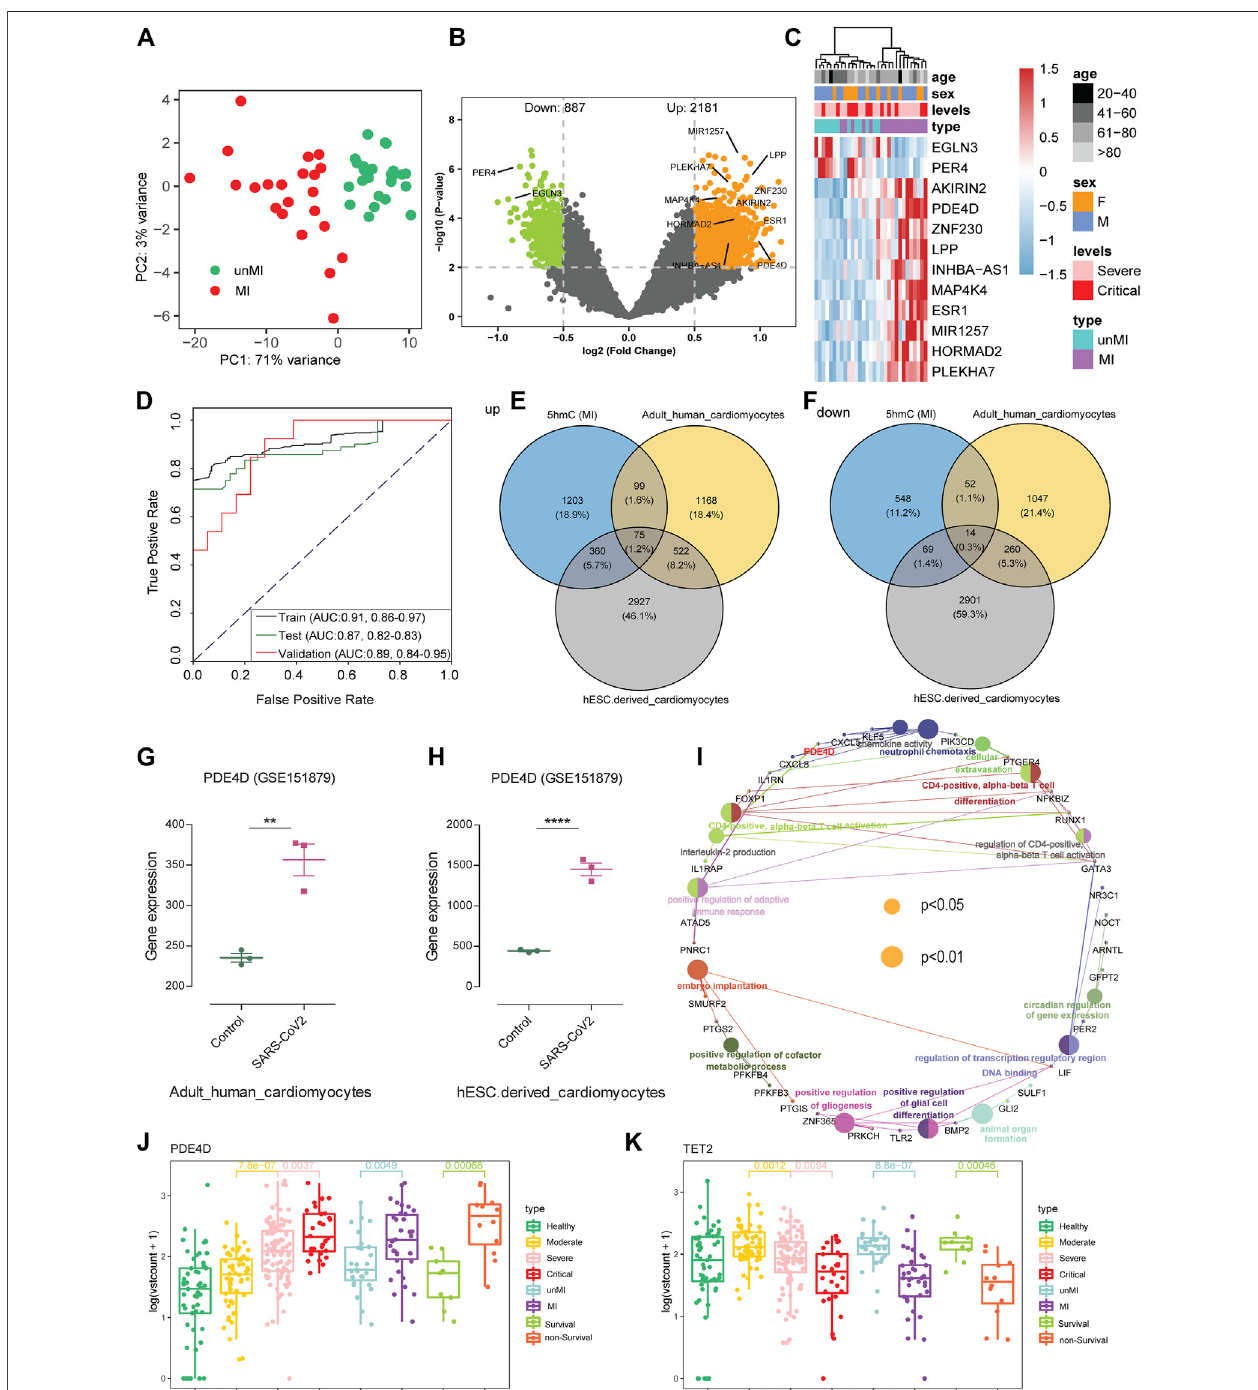
FIGURE 4 | 5-Hydroxymethylcytosine signatures as early warning biomarkers for myocardial injury. (A) Principal component analysis (PCA) using normalized read countsfrompatientswithmyocardialinjury(MI)andthosewithoutMI(unMI). (B) VolcanoplotofhMRs(MIpatientsvs.unMIpatients). (C) Heatmapsof125hmCmarkers with myocardial injury patients, levels, sex, and age information labeled in the validation cohort. Hierarchical clustering was performed across DhMRs-associated genes and samples. (D) ROC curve of the warning model with DhMRs in training and validation cohorts for myocardial injury. (E,F) Venn diagram indicating overlap and speci fi city of increase (E) or decrease (F) in myocardial injury patients from 5hmC-seq and RNA-seq (GSE151879) dataset. (G,H) The expression data are from the GSE151879 dataset. Each dot represents one healthy person or myocardial injury patients; error bars represent mean values. Statistically signi fi cant p values are indicated with asterisks (** p < 0.01 and **** p < 0.0001, by t -test). (I) GO enrichment and Gene-Concept Network with overlapping genes in myocardial injury patients.